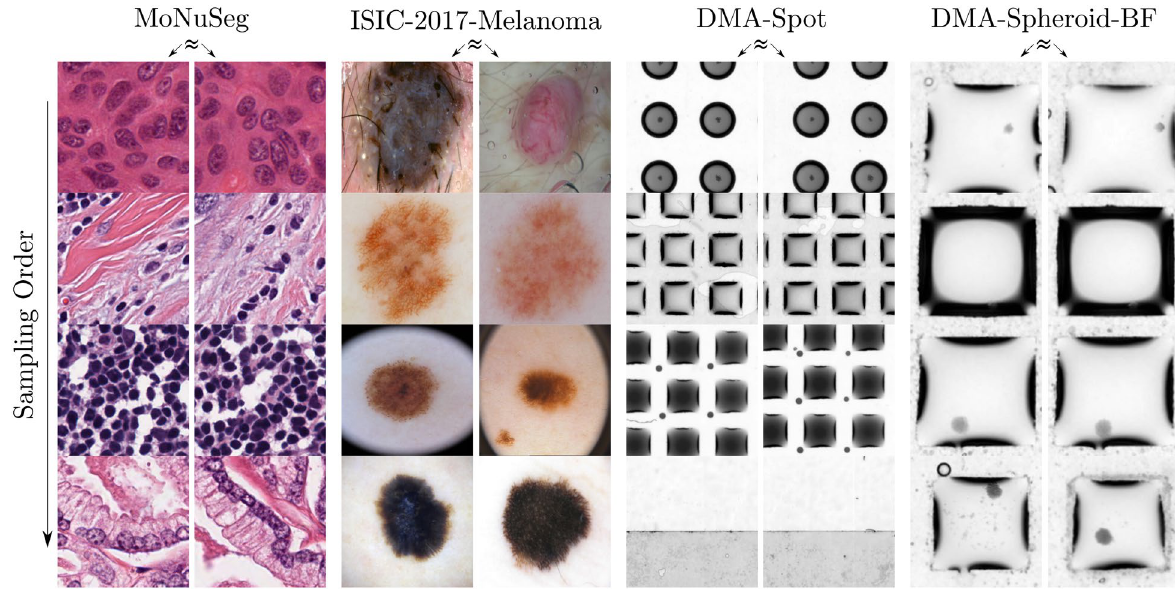
Figure 9. Automated Selection Based on Dataset Heterogeneity. Using ResNet18 in combination with PCA on ten features, the selection order (left row) for different datasets (MoNuSeg 12 , ISIC-2017-Melanoma 11 , DMA- Spot, DMA-Spheroid-BF) is visualized. In addition, the images with the highest similarity ( ≈ ) are compared row by